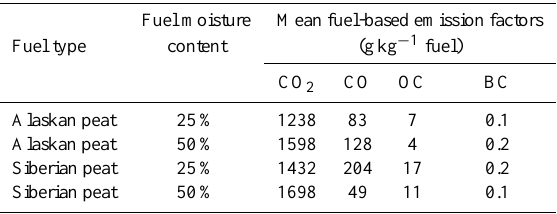
Table 1. Mean mass-based emission factors (rounded to nearest integer) of carbonaceous gases and aerosols from emissions of Alaskan and Siberian peat in this study.